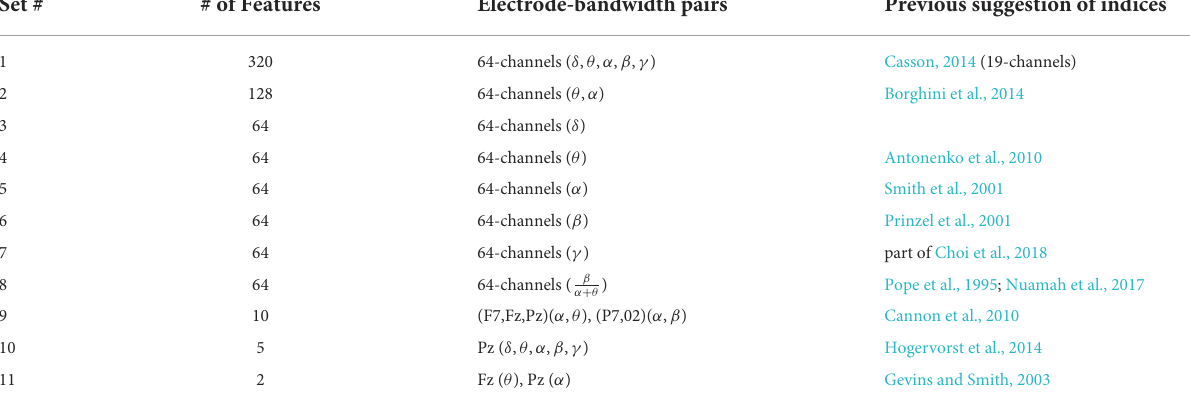
TABLE 1 The full model and 10 electrode-bandwidth